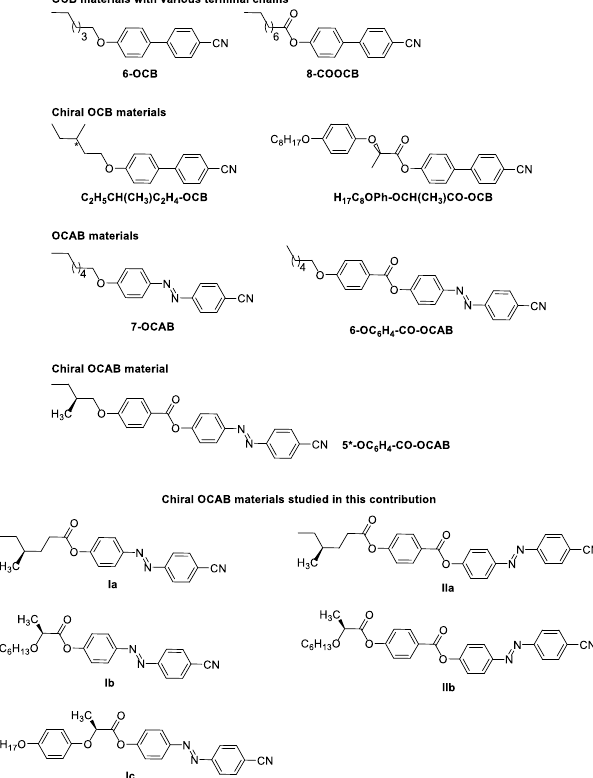
Figure 1. Structures of the materials derived from 5-CB and materials studied here. Chiral centers are indicated by asterisk or by defined position one of the substituents. References to the depicted compounds are provided later in the text .